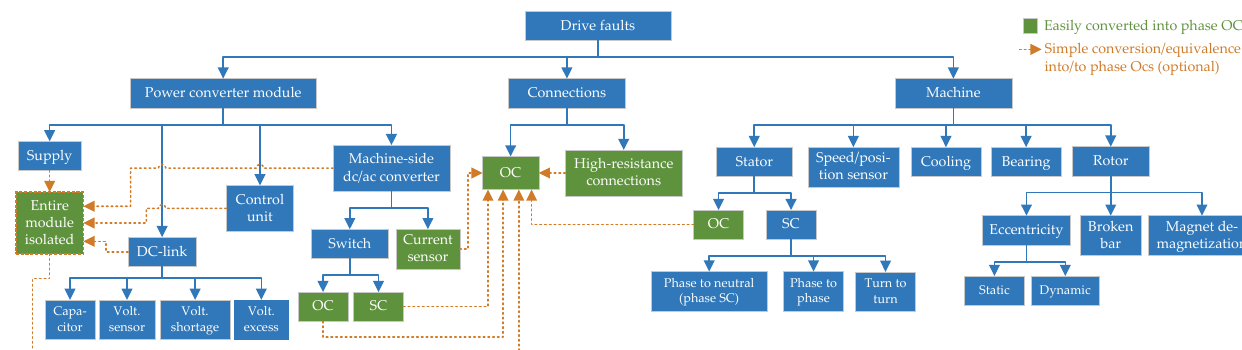
Figure 1. Types of faults in an ac